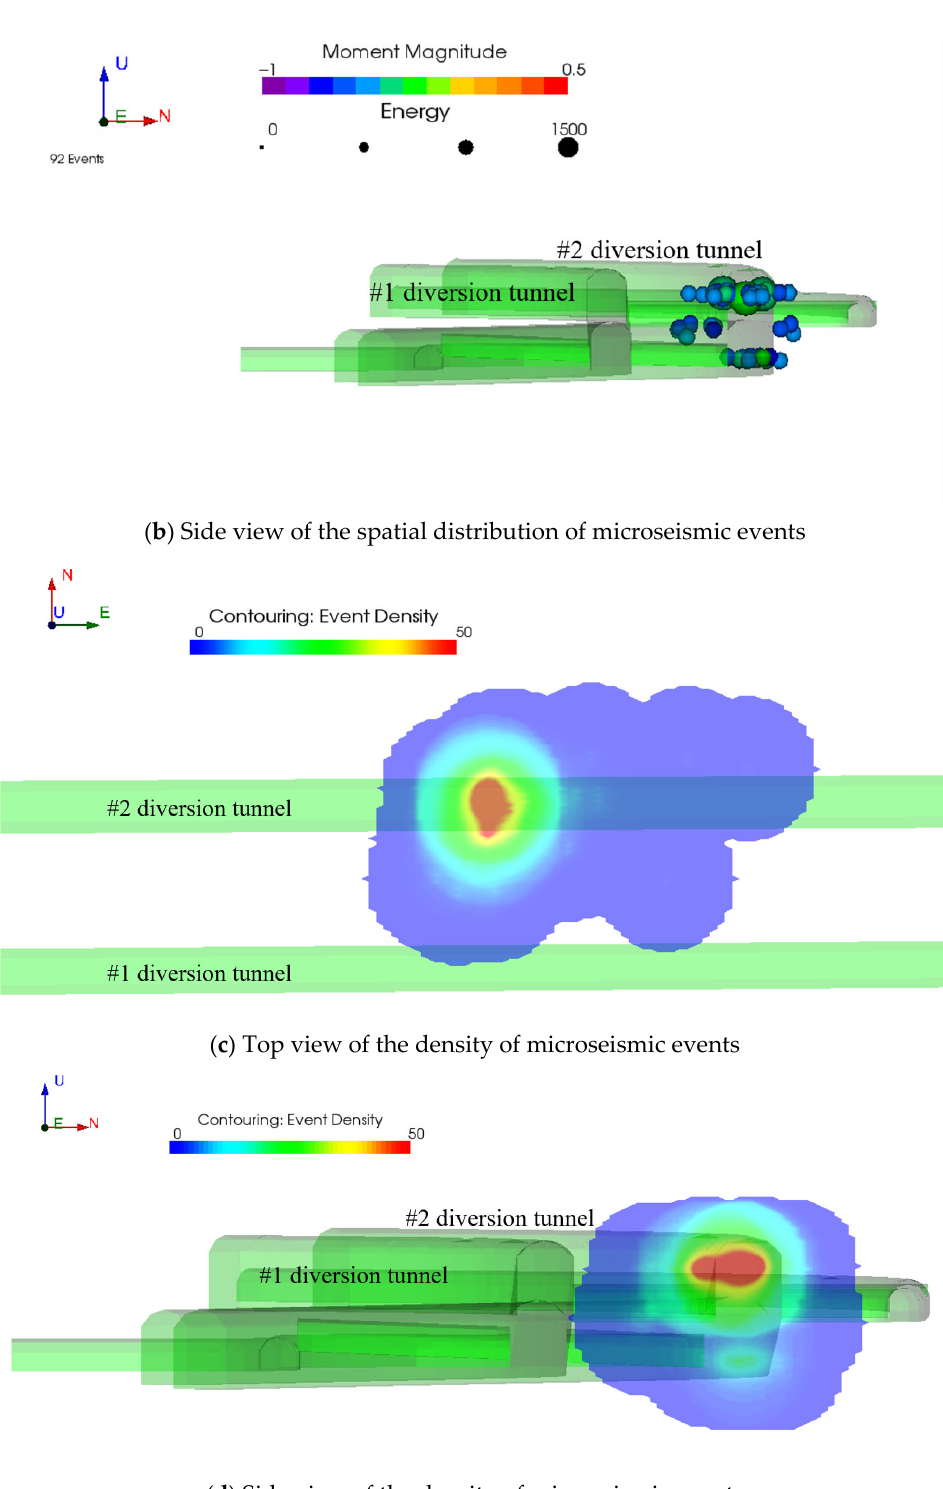
Figure 12. Spatial distribution of microseismic events.